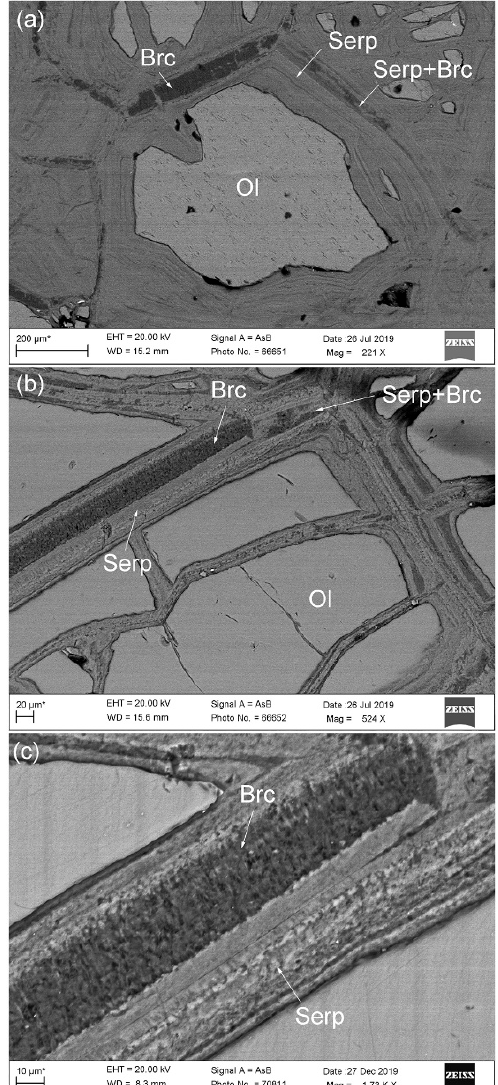
Figure 4. Representative electron back-scatter (BSE) images of jianite displaying various degrees of hydration and a hierarchic fluid-transporting system. ( a ) The olivine grain in the middle (surrounded by serpentine and brucite), in which needle-shaped fine mineral inclusions align along certain special crystallographic orientation, shows relatively weak serpentinization. In comparison, the olivine grain in the upper left part of the image (broken down into several relatively large olivine fragments) shows relatively strong serpentinization, that in the upper right part (broken down into many relatively small olivine fragments) shows strong serpentinization, and that either in the left part or in the right part (completely replaced by serpentine and brucite) shows complete serpentinization. ( b ) A hierarchic fluid-transporting system displayed by grain boundaries and cracks of different widths (from > 60 to < 10 μ m) near a ruptured olivine grain, which is filled with serpentine aggregates and brucite aggregates. The examined area is generally the lower left part of the sample shown in Figure 3c,d. In most cracks, two layers of serpentine aggregates, thick or thin, generally occur next to the olivines and sandwich a layer of brucite aggregates. In some cases, the serpentine aggregates and brucite aggregates may form interbedded thin layers and display complicated textures. ( c ) A close-up view of the serpentine aggregates and brucite aggregates along the grain boundary in the upper left part of (b). Note that the olivine grain is almost inclusion-free, suggesting a weak serpentinization reaction. Ol, olivine; Serp, serpentine; Brc, brucite.